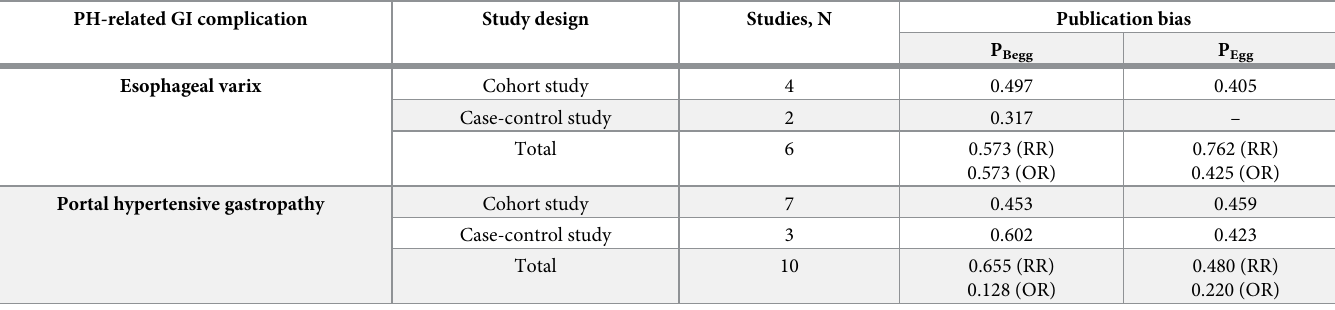
Table 3. Publication bias of studies conducted by Begg’s rank correlation test and Egger’s regression test. PH-related GI complication